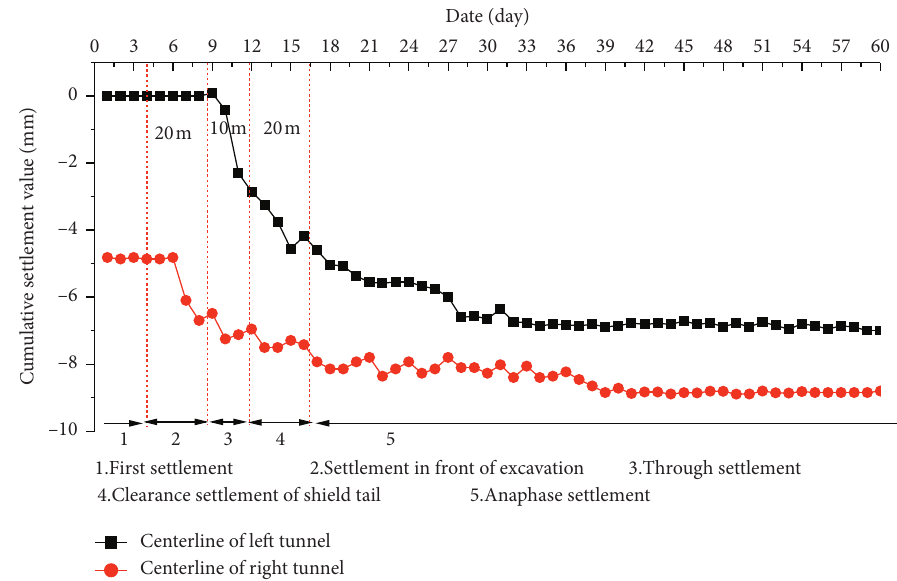
Figure 13: The settling time curve of the ground when the right-line shield passes through (test section).